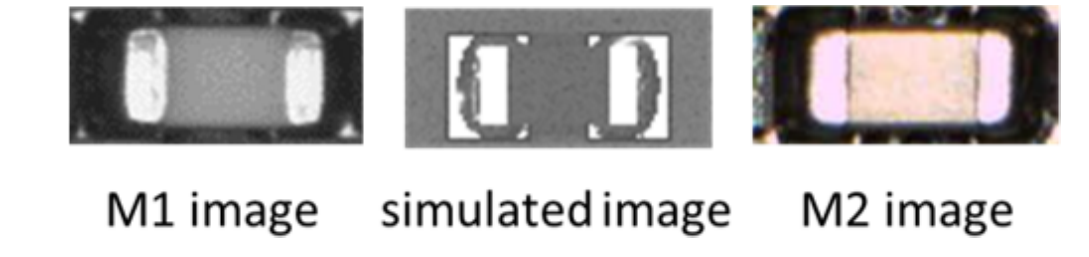
Figure 2. Overview of used image